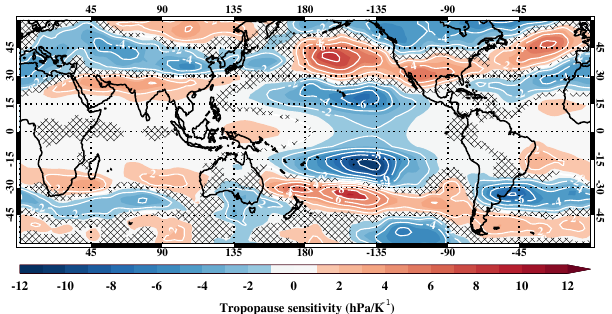
Figure 9. The sensitivity of tropopause pressure to the Niño 3.4 index from linear regression over 2005-2013. The sensitivity is ex- pressed as the change in tropopause pressure per degree change in the index (hPaK − 1 ). Crosshatched regions denote where the sensi- tivity is not statistically different from zero at the 95% confidence level. White contours are incremented every 2hPaK − 1 .